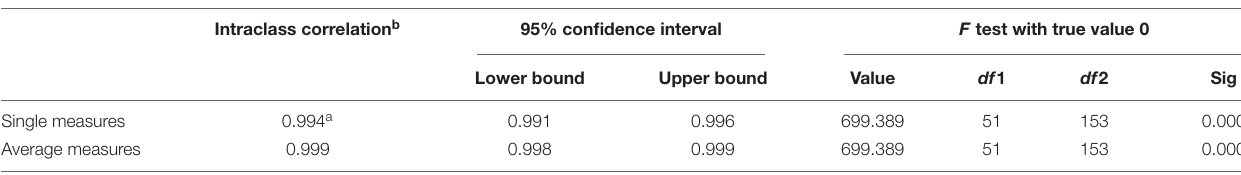
TABLE 5C | Intraclass correlation coefficient.